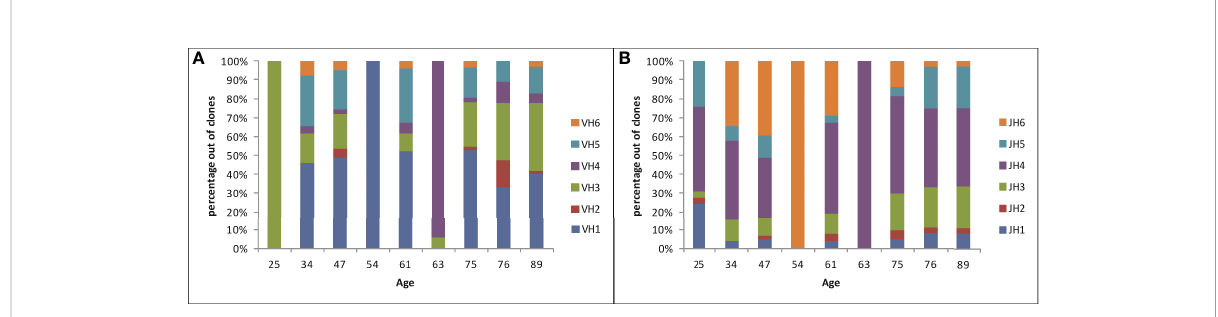
FIGURE 2 V and J gene family usage in Ig heavy chains in gastric DLBCL vs. age, plotted as the percentages of clones using each gene family in each sample. (A) V gene family usage. (B) J gene family